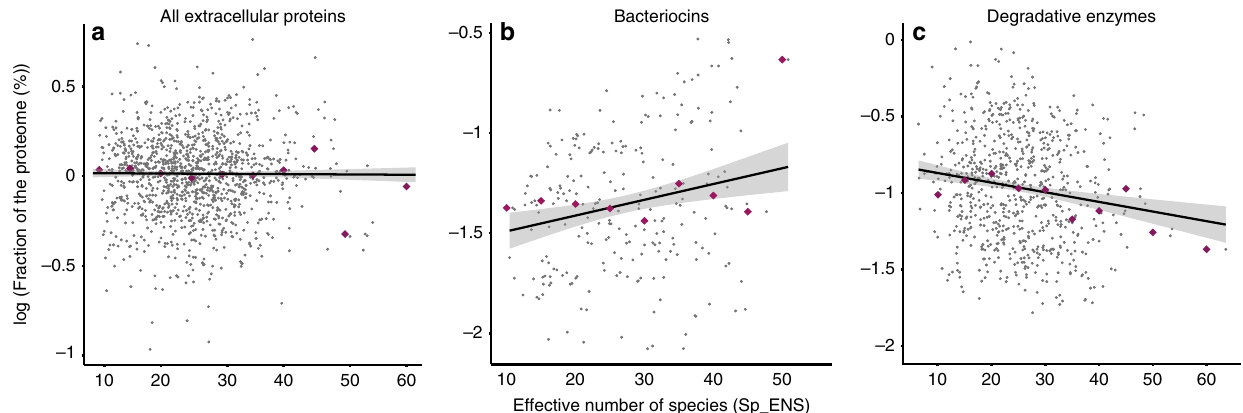
Fig. 4 Frequency of genes encoding extracellular proteins (in Y axis) and its association with the alpha diversity (measured as the effective number of species, in X axis). Dots in blue represent individual species, while purple diamonds represent the median values of each percentile. The shaded black line represents the linear regression associated to each distribution. Each panel represents one speci fi c dataset: a Extracellular proteins (Spearman correlation ρ = 0.002, P = 0.482); b Extracellular bacteriocins ( ρ = 0.18, P MCMC = 0.006, regression statistics: a = 0.362, b = 0.08, r 2 = 0.048, P < 0.05); c Degradative enzymes ( ρ = − 0.16, P MCMC = 0.0003, regression statistics: a = − 0.267, b = 0.564, r 2 = 0.063, P < 0.05). Source data are provided as a Source Data fi